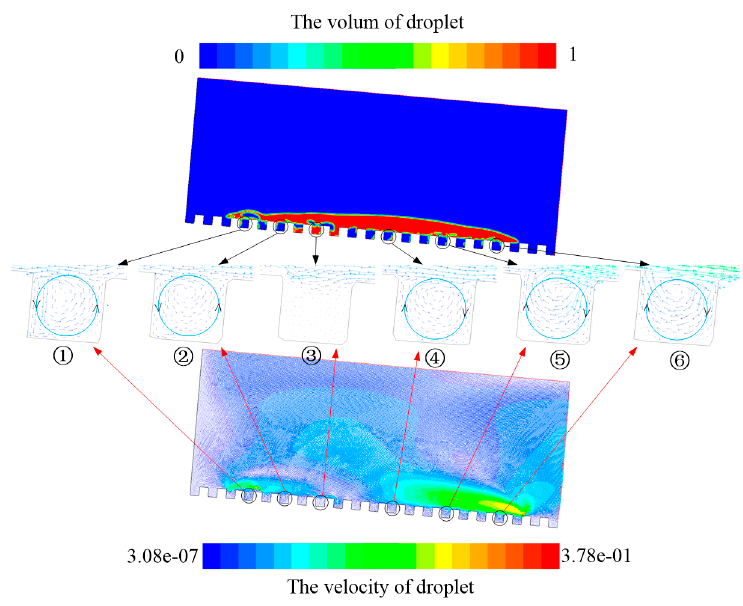
Figure 11. Schematic diagram of the pit air vortex.